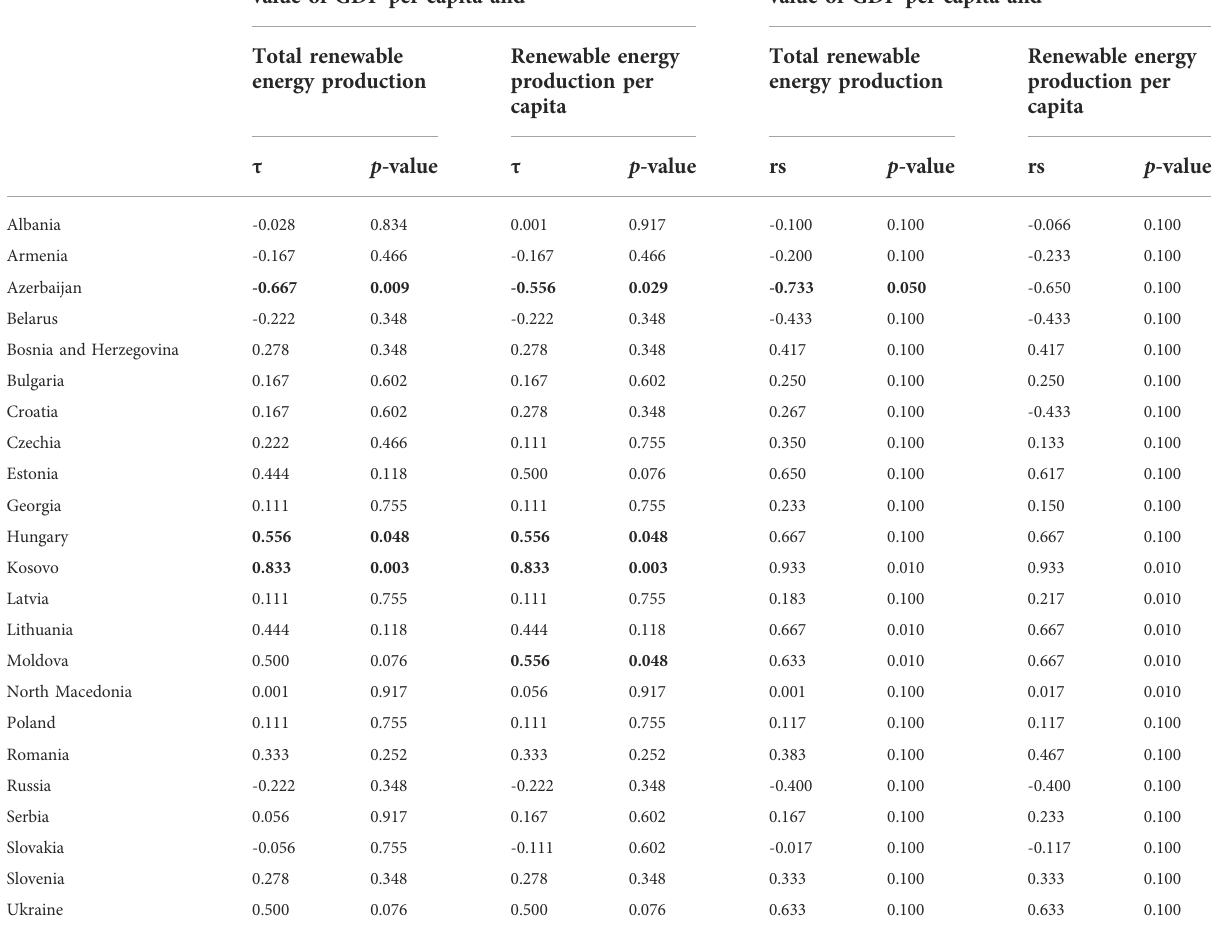
TABLE 1 Kendall ’ s Tau Correlation Coef fi cients and Spearman ’ s Rank Correlation Coef fi cients between the value of GDP per capita and the parameters of renewable energy production. Countries Kendall ’ s tau correlation coef fi cient between